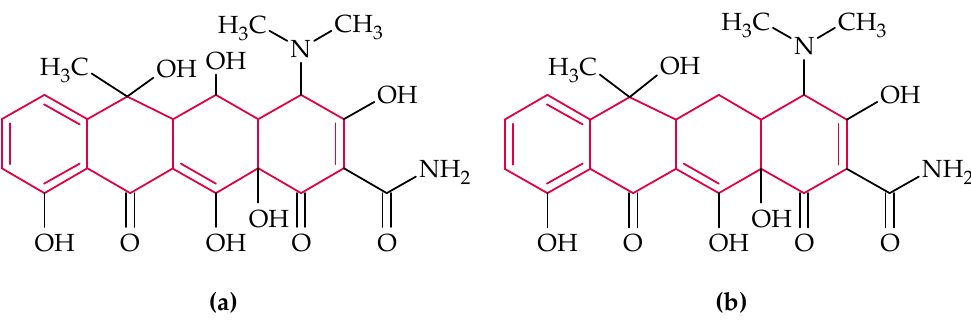
Figure 8. Chemical structure of: ( a ) oxytetracycline and ( b ) tetracycline. The basic structure of the tetracyclines is marked in red.